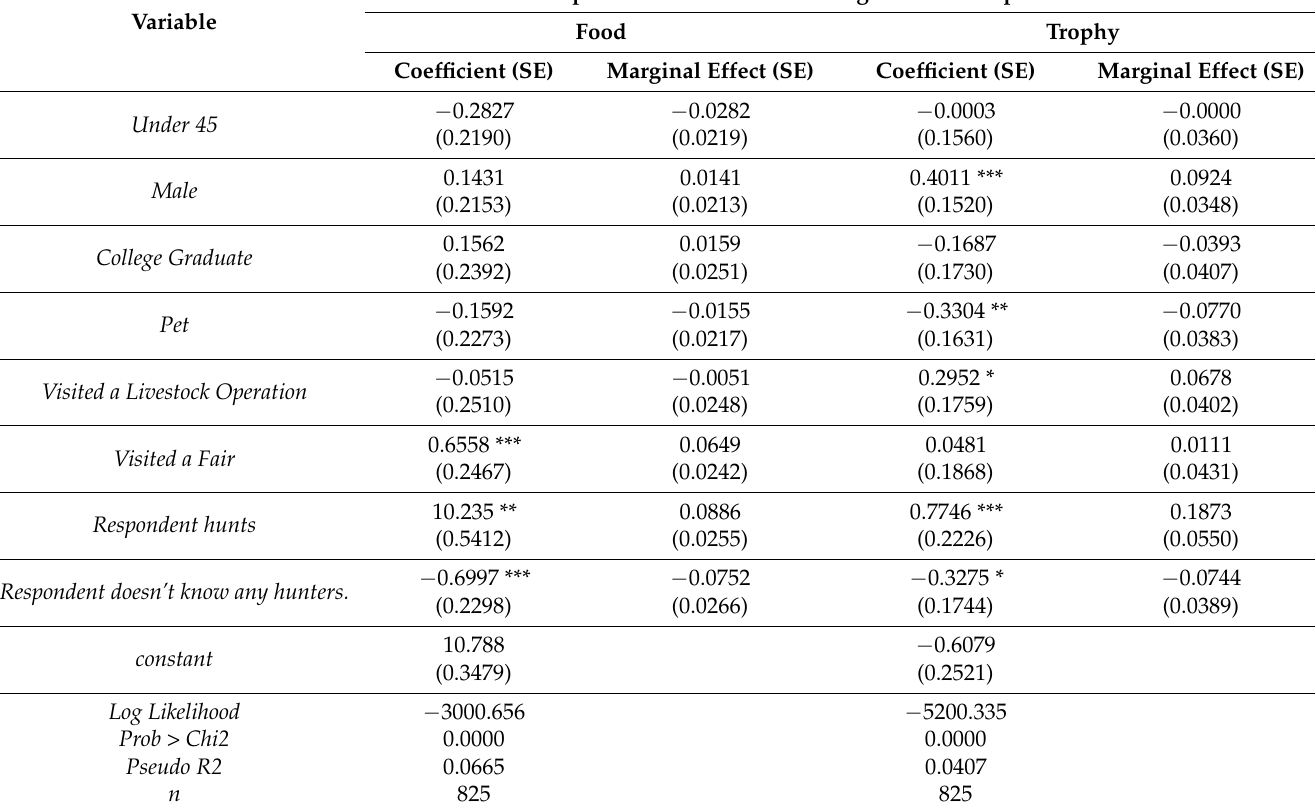
Table 5. Logistic regression results for agreement with reasons to